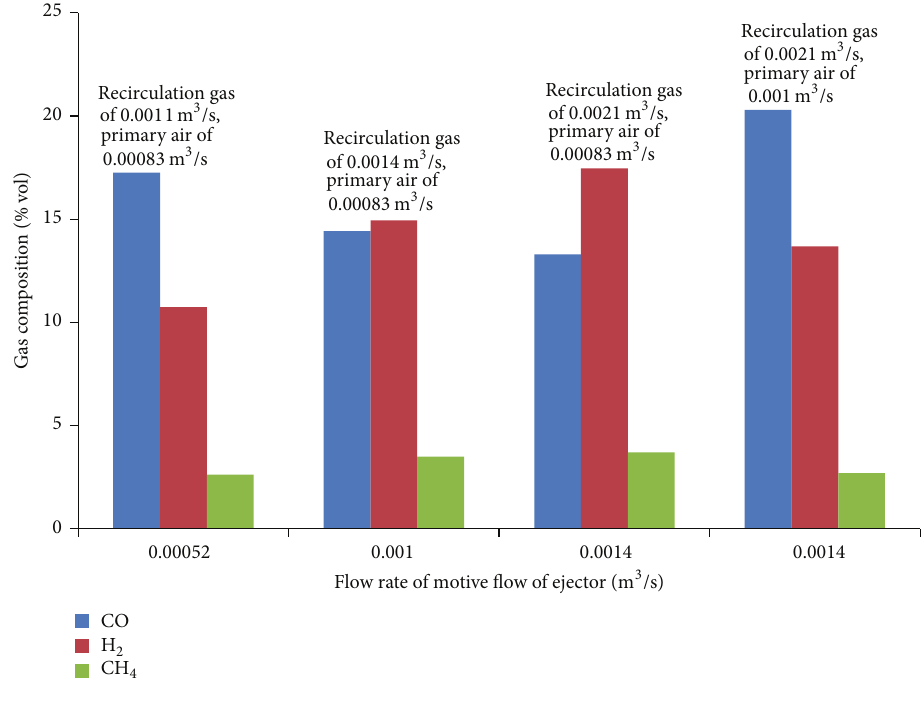
Figure 3: Gas concentration versus motive flow